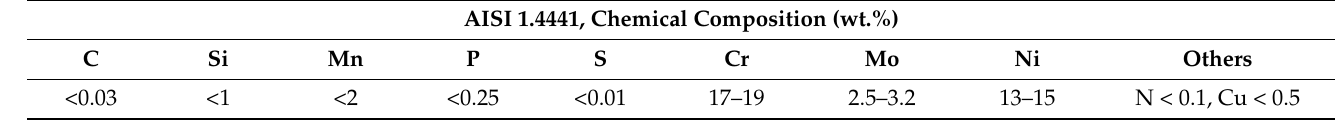
Figure 1. Anterolateral distal tibial plate with marked areas of analysis . Table 1. Standardized chemical composition of 1.4441 steel according to [7] .